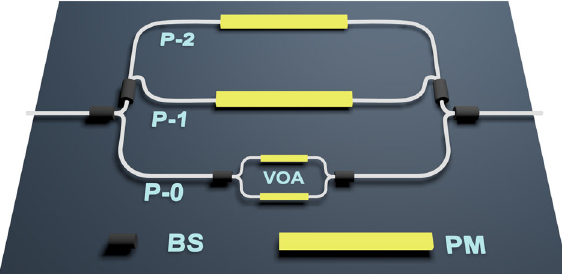
Fig. 4 The fi gure depicts the structure of the DPMZI, which contains two parallel sub-MZI. In our modulation method, one of the MZIs is regarded as a VOA.